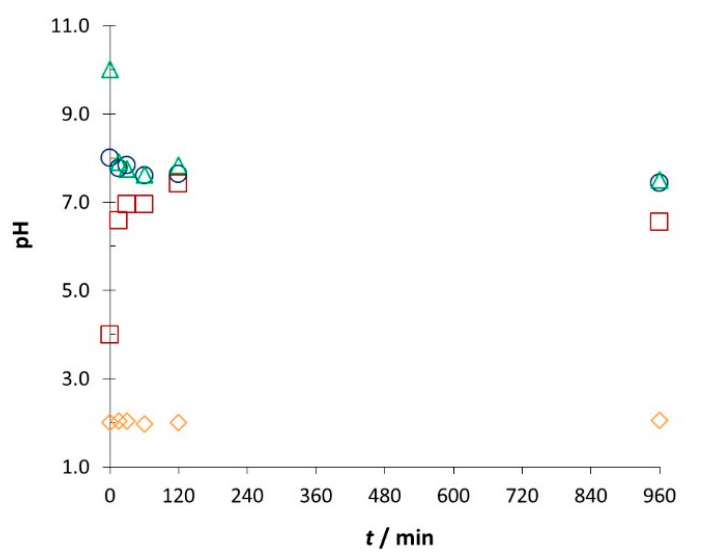
Figure 2. pH profiles of RB5 dye after adsorption for four initial pH values after appropriate time of adsorption ( t ) ( pH 0 = 2.00; pH 0 = 4.00; pH 0 = 8.00; pH 0 = 10.00.